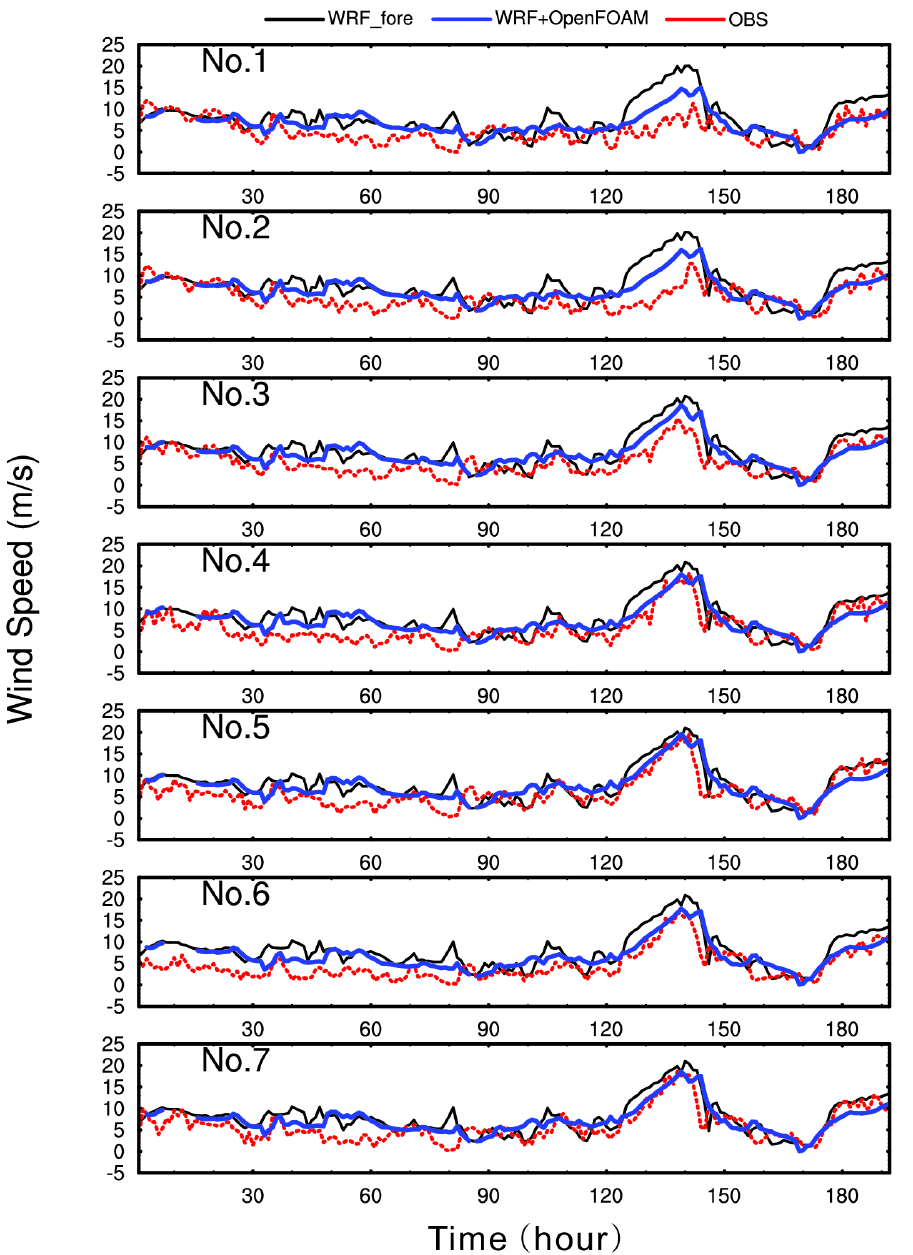
Figure 3. The WRF forecasts (“WRF_fore”), the predictions of the coupled system (“WRF+OpenFOAM”) and the corresponding observations (“OBS”) of seven turbines for 192 cases, from 00:00 UTC 2 October to 23:00 UTC 9 October